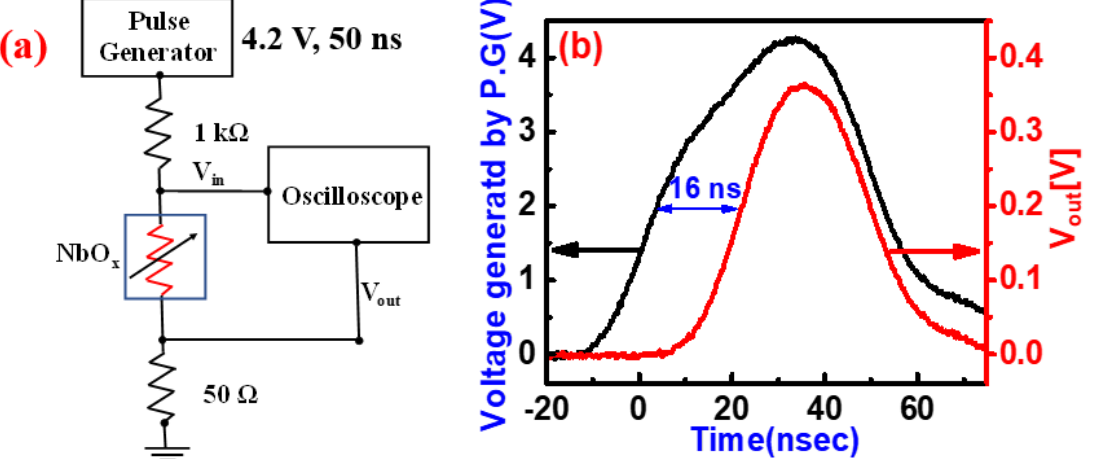
Figure 5. ( a ) Circuit Configuration of W / WO y / NbO x / Pt device speed measurement, ( b ) Real-time oscilloscope measurements during the SET pulse condition.